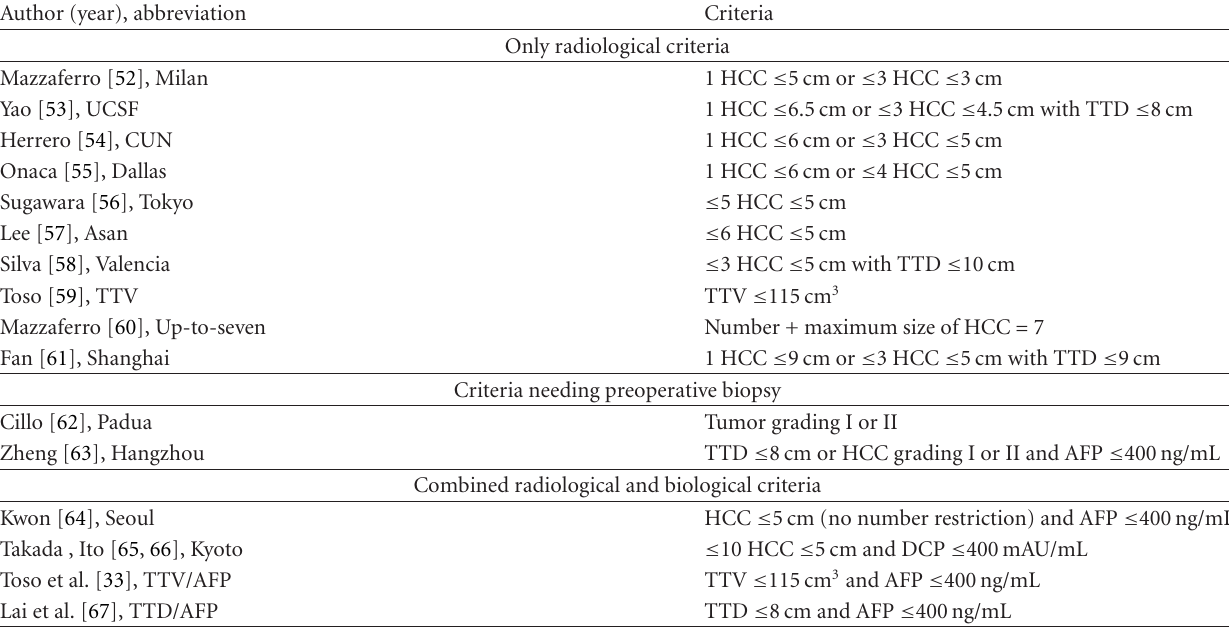
Table 1: Various proposed criteria for the selection of HCC patients waiting for liver